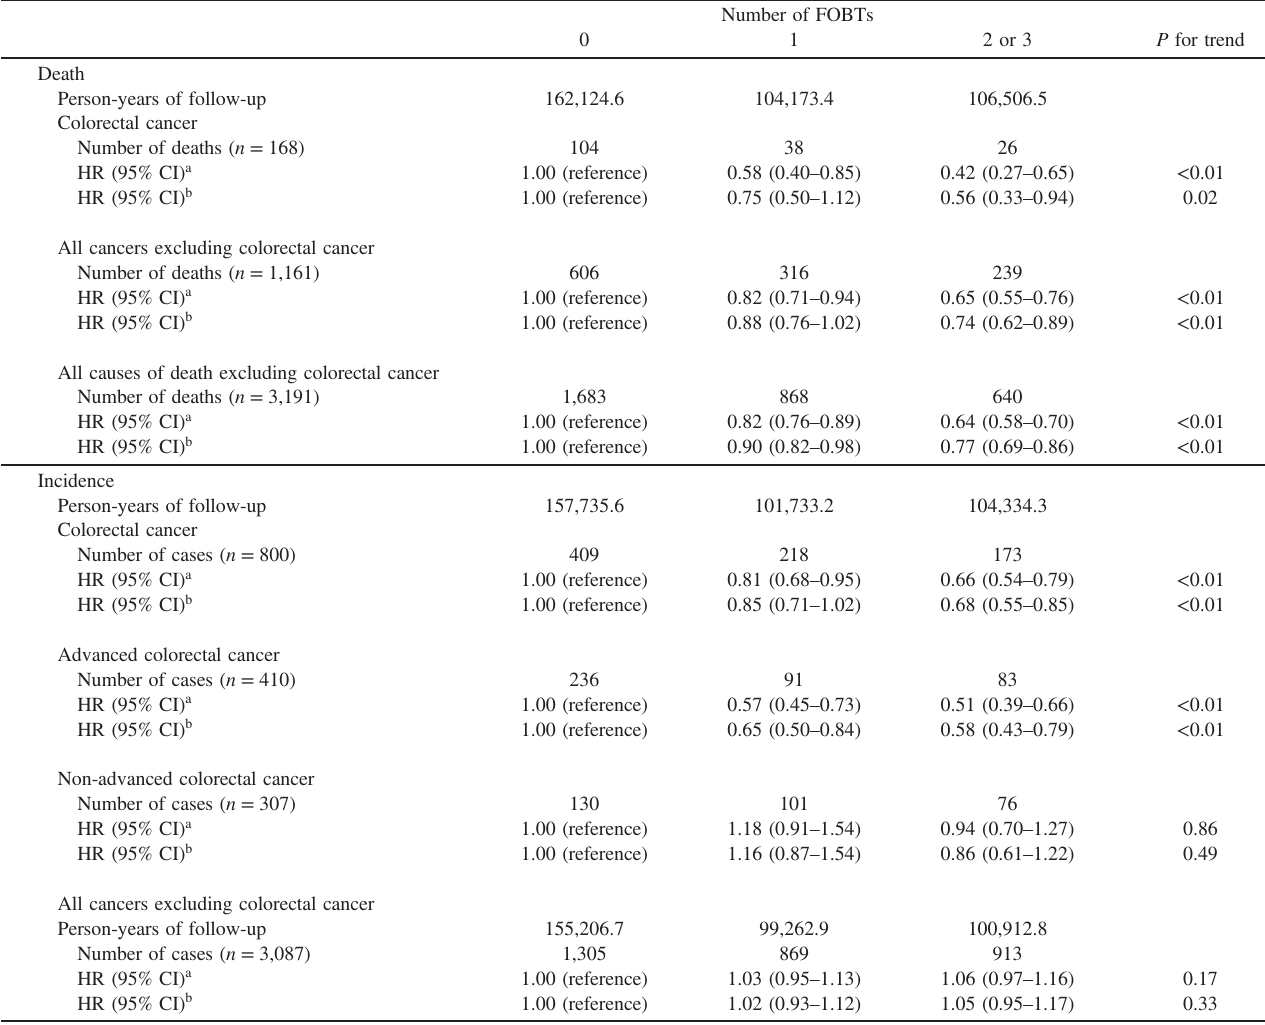
Table 3. Hazard ratio and 95% con fi dence interval for the number of FOBTs and subsequent risk of colorectal cancer in 27,974 subjects in the JPHC